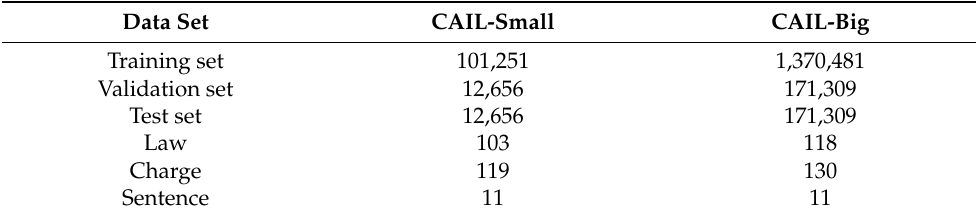
Table 2. Statistical analysis of the data set.